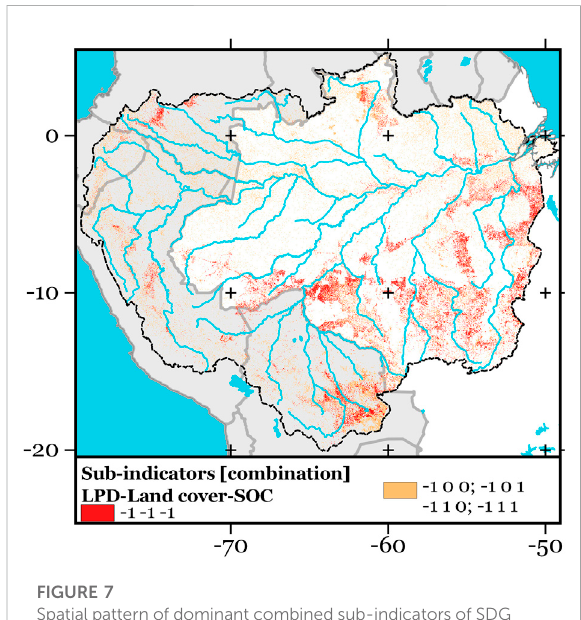
FIGURE 7 Spatial pattern of dominant combined sub-indicators of SDG indicator 15.3.1 in the Amazon basin for 2001 – 2020. Where “ − 1 ” depicts Degraded, “ 0 ” is Stable, and “ 1 ” is Improvement for each sub-indicator. All sub-indicators combinations are listed in Supplementary Figure